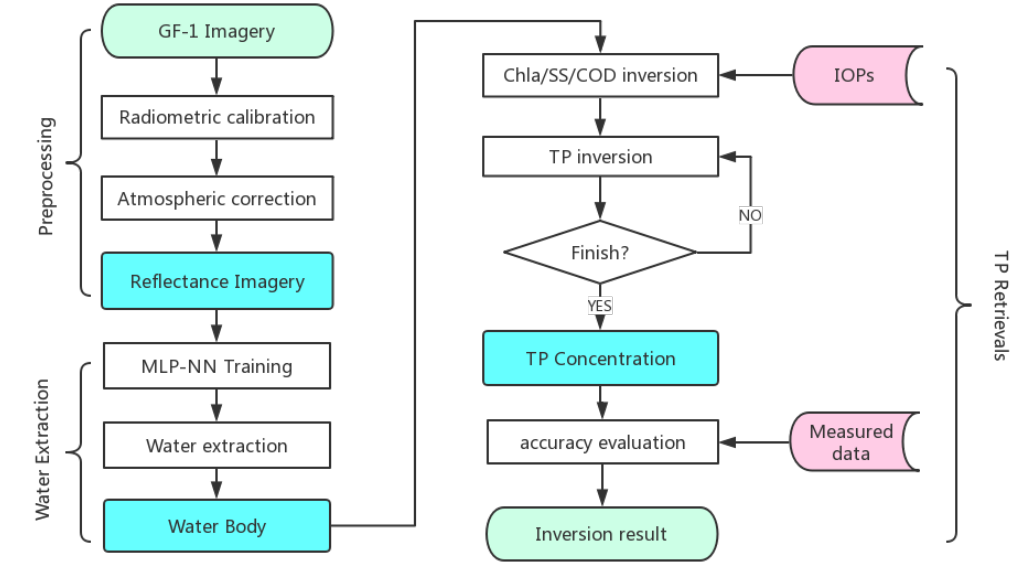
Figure 3. Flow chart of remote sensing retrieval of total phosphorus (TP).